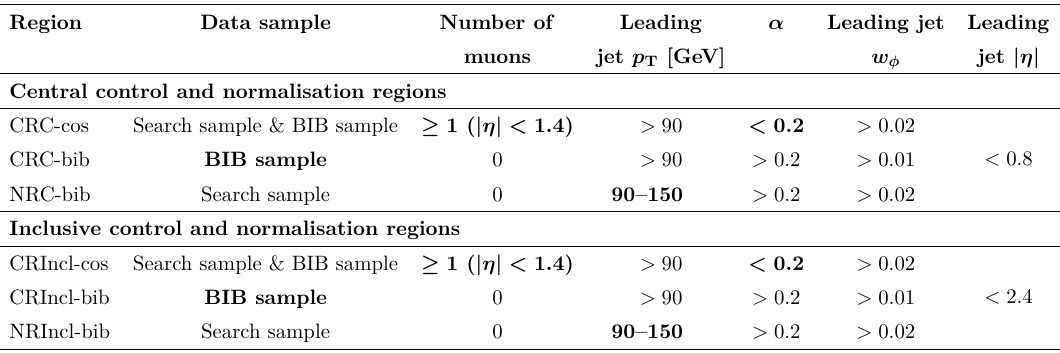
Table 3 . Overview of the control and normalisation regions used to estimate the contribution of background processes to the SRs. The main requirements that distinguish the control and normalisation regions from the signal regions are indicated in boldface. Events for which α cannot be determined are included in the α > 0 . 2 selection CR(Incl/C)-bib and NR(Incl/C)-bib.